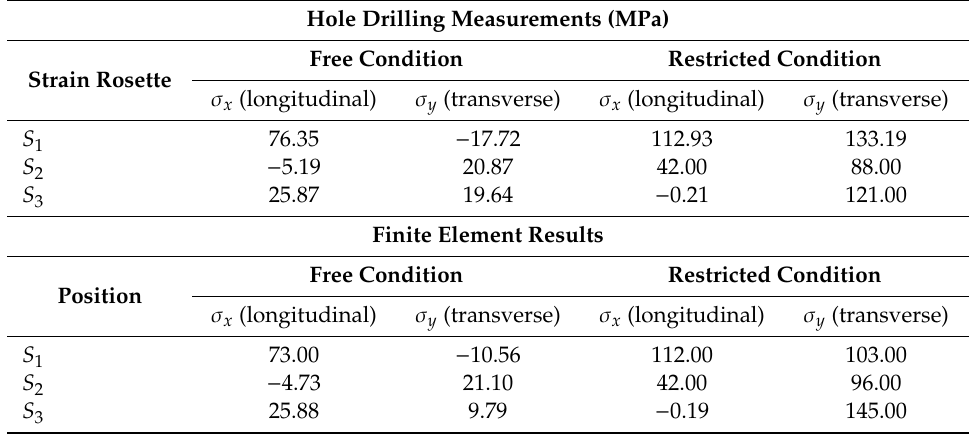
Table 4. Experimental and finite element results for the longitudinal and transverse residual stresses. Hole Drilling Measurements (MPa) Free Strain Rosette